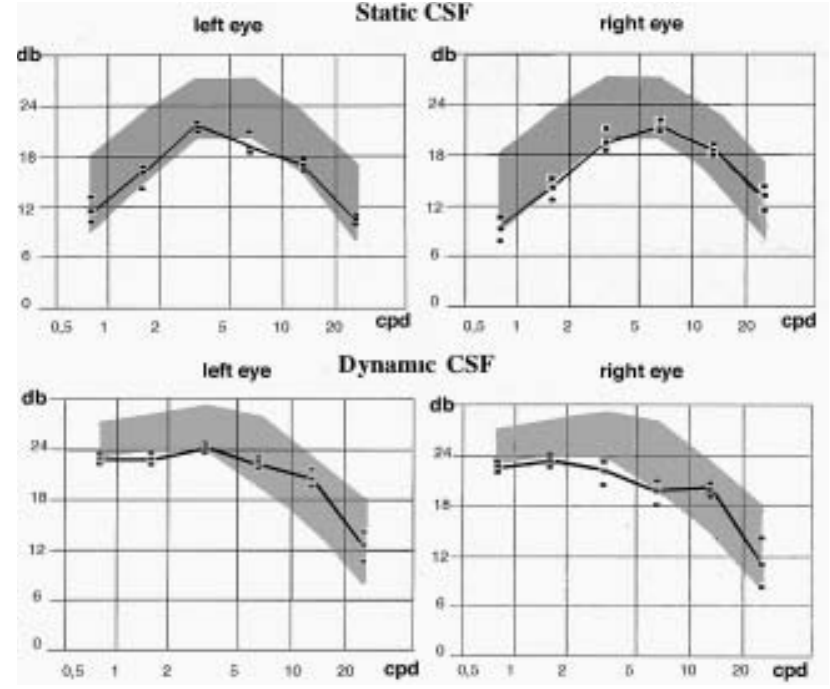
Fig. 3. Contrast sensitivity was low but near normal (gray